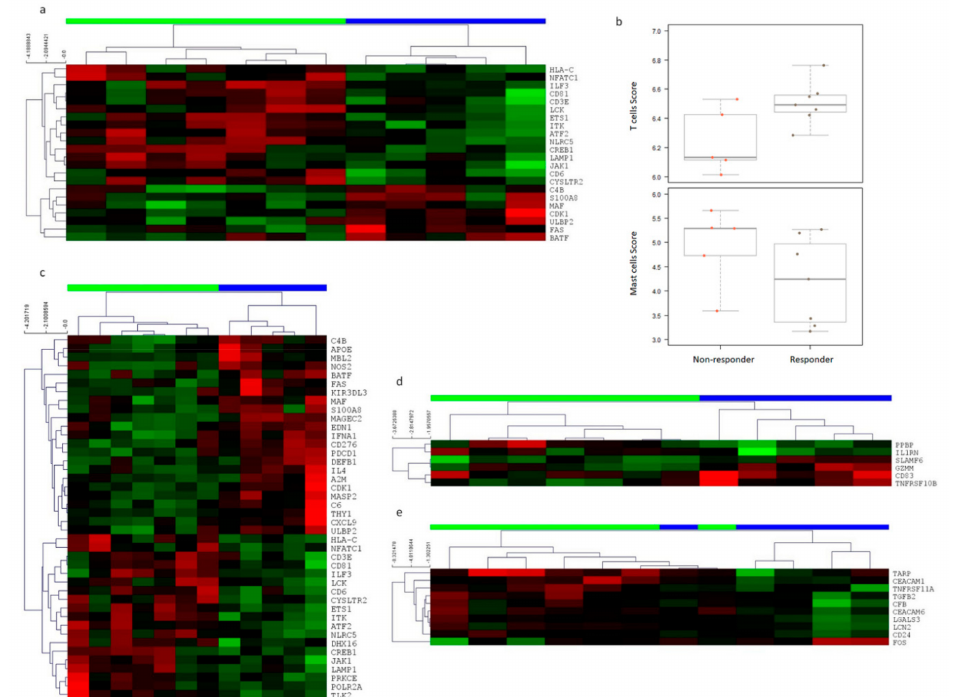
Figure 1. Immune gene expression in nasal lysate samples and whole blood at baseline and following supplementation in responders and non-responders. ( a ) Baseline whole-blood immune gene expression in responders vs. non-responders found 24 significantly differentially expressed genes (DEGs) between the groups. ( b ) Based on cell type scores, responders had a significantly higher abundance of T-cells and a trend for a lower abundance of mast cells in blood at baseline compared to responders (1: responders; 2: non-responders). ( c ) There were 42 genes significantly differentially expressed between responders and non-responders in nasal lysate samples at baseline. ( d ) Following supplementation, six immune genes in blood were significantly differentially expressed ≥ 1.5-fold between the groups. ( e ) There were 10 immune genes significantly different at ≥ 1.5-fold ( p < 0.05) in nasal lavage / brushing samples between the groups. For Figure 1 ( a , c , d , e ) each row represents a gene (red: high expression; green: low expression) and each column a patient (green: responder; blue: non-responder). Rows are Z-score normalised.